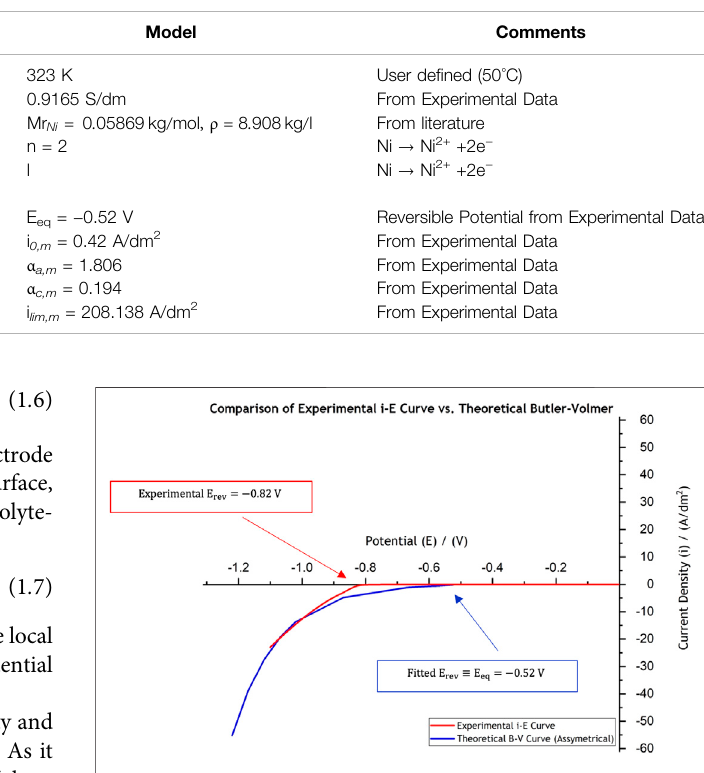
FIGURE 2 | Comparison of the experimentally collected data in the laboratory using linear sweep voltammetry (red curve) against the theoretical current-potentialbehaviourforuseinNielectroformingmodels, “ shifted ” B-Vcurve (blue line). The linear sweep voltammetry was conducted at a scan rate of 0 . 005V/s,50 ℃ andunderagitationat1500rpm.Thekineticparametersusedto plot the theoretical Butler-Volmer curve were the ones presented in Table 1 . [ 1A/dm 2 (cid:1) 100A · m − 2 ]